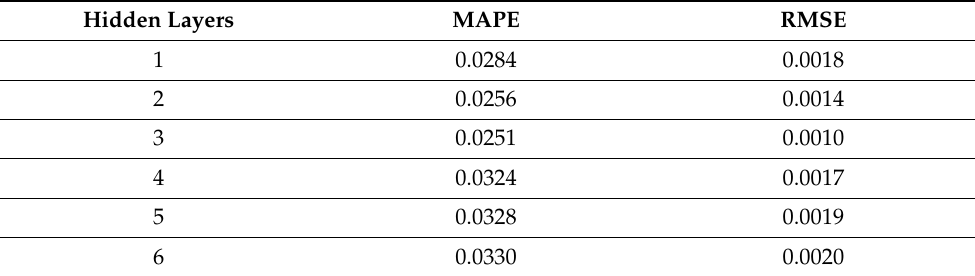
Table 3. Performance of the stacked ANN with different hidden layers for the drug recommenda- tion